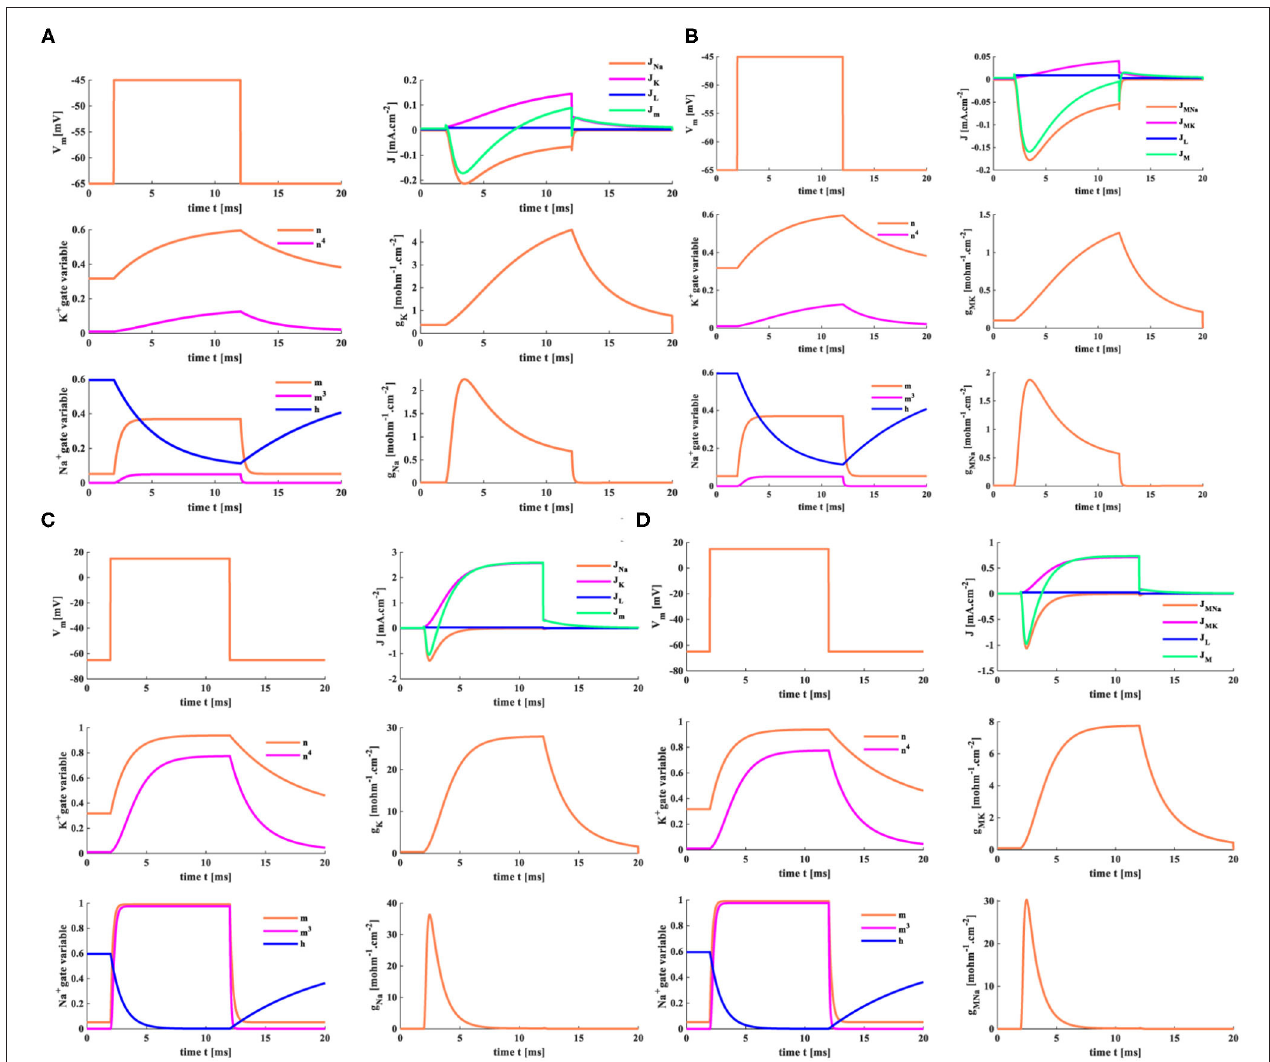
FIGURE 10 | The distinct clamp voltages are applied to the HH spiking model and the MHH spiking model. (A) The HH model with V clamp = 20 mV. (B) The MHH model with V clamp = 20 mV. (C) The HH model with V clamp = 80 mV. (D) The MHH model with V clamp = 80